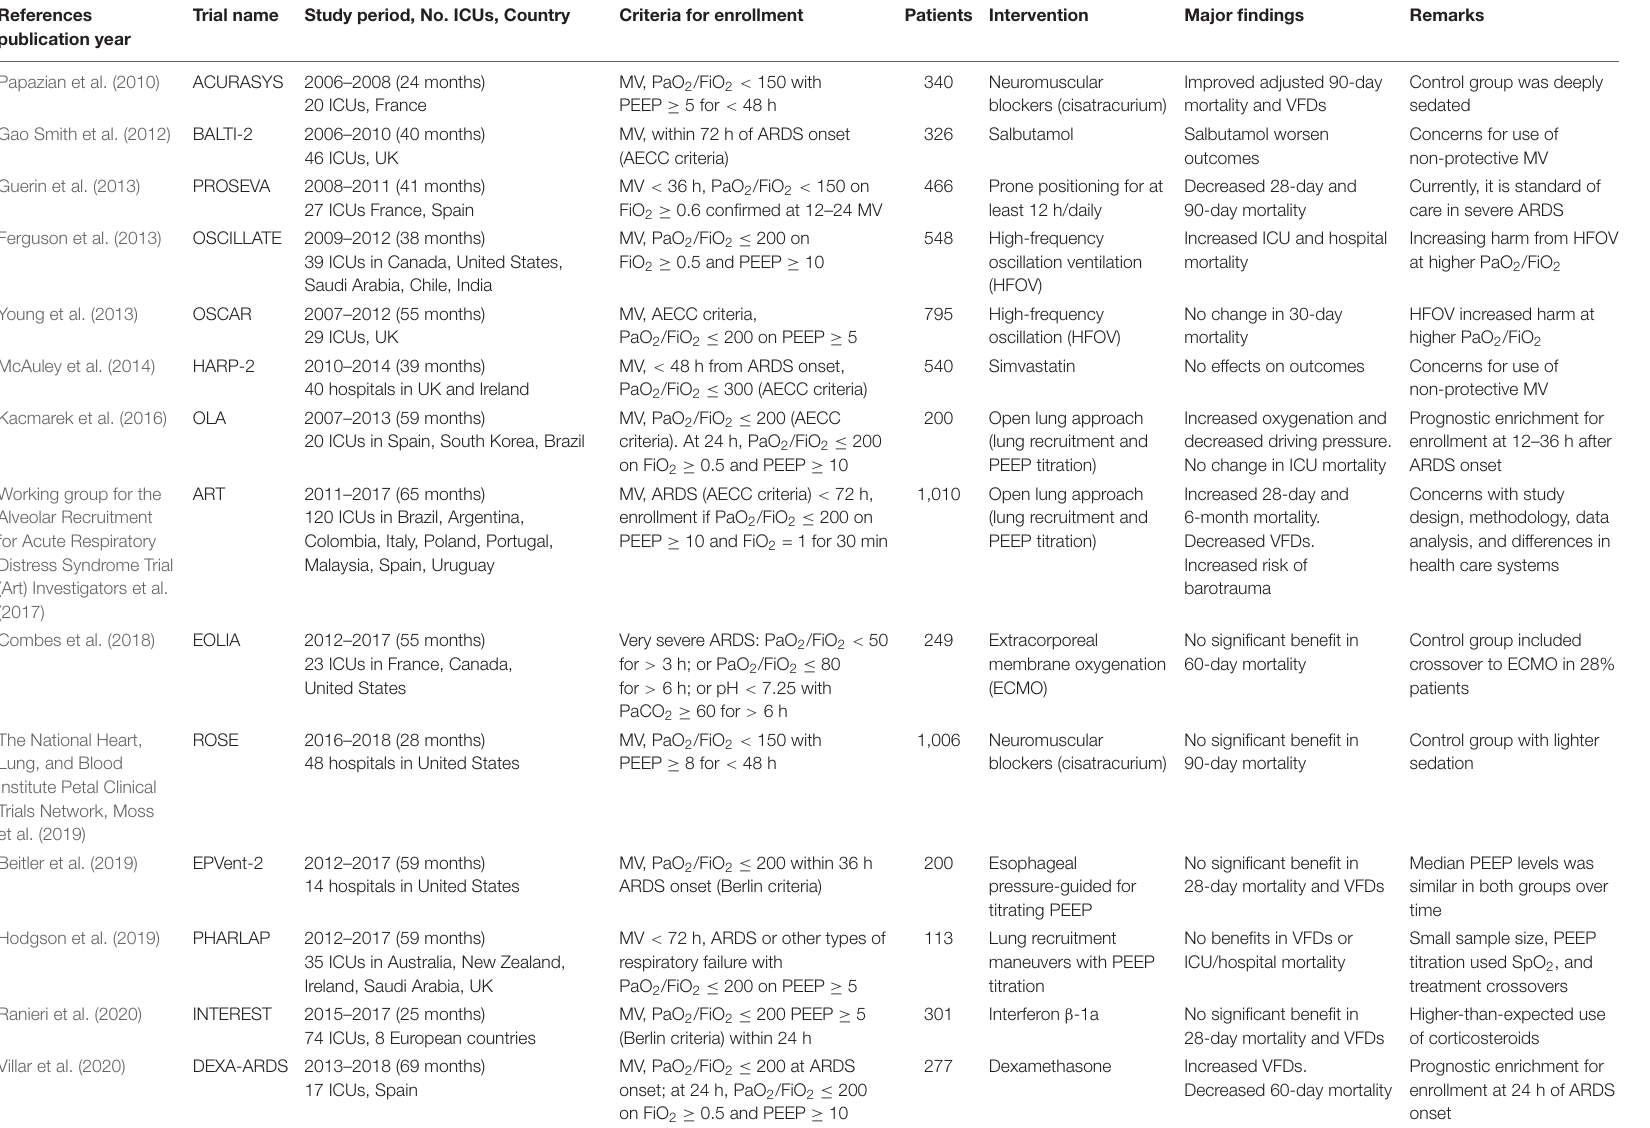
TABLE 1 | Successful and unsuccessful randomized clinical trials since 2010 in ventilated patients with acute respiratory distress syndrome